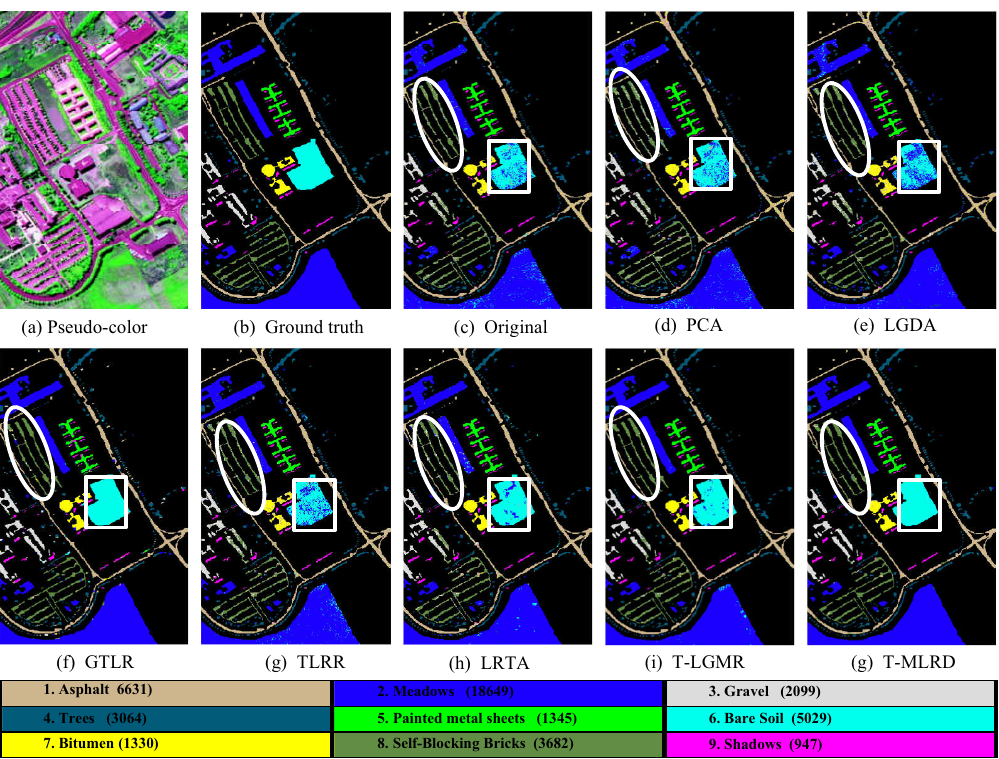
Figure 5. Classification maps of different methods on the Pavia University dataset.